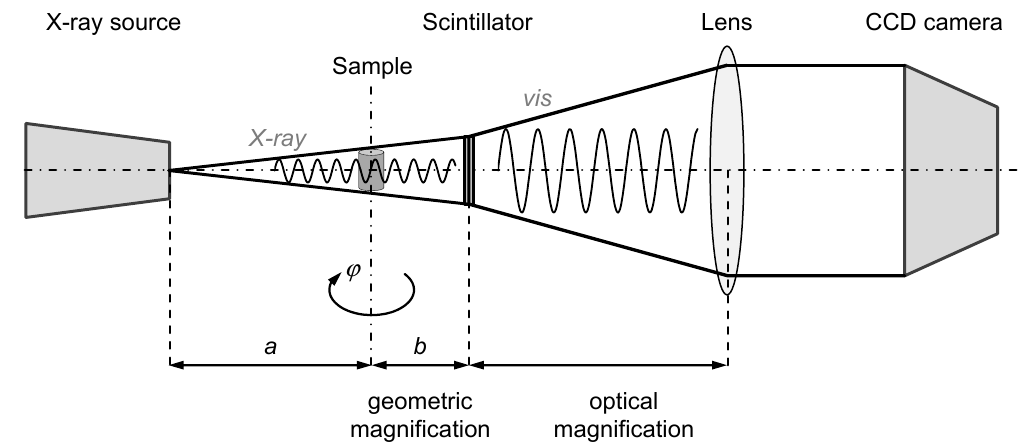
Figure 5. Working principle of an X-ray microscope combining geometric and optical magnification for increased spatial resolution.